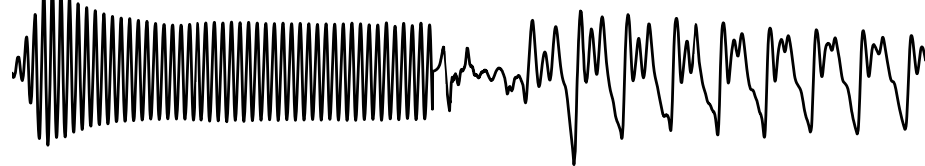
Figure 18. Example of tvconv buffer content if freezing is allowed at an arbitrary point. Old content remains in the latter part of the buffer while the first part has been written with new